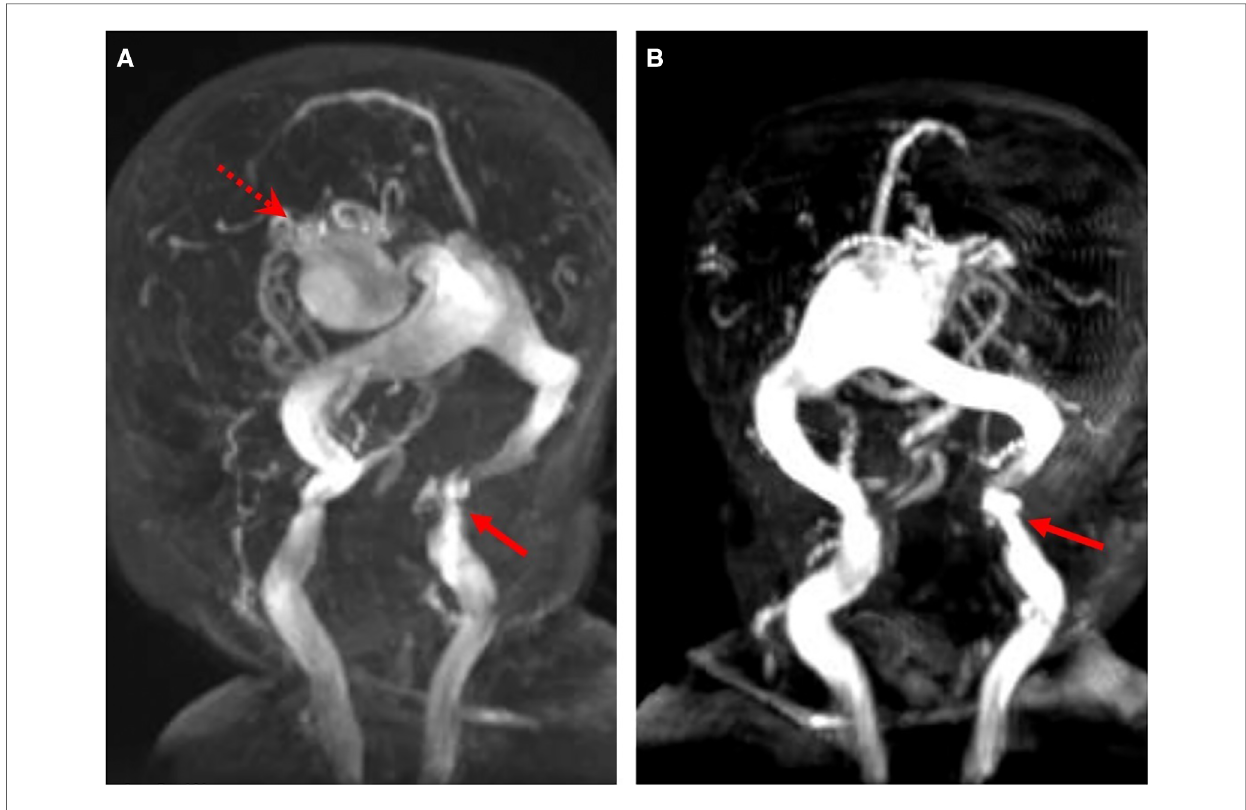
FIGURE 2 Magnetic resonance angiogram images show the VGAM (red dotted arrow) and the stenosis of the left jugular bulb (red arrow) ( A,B ) in patient